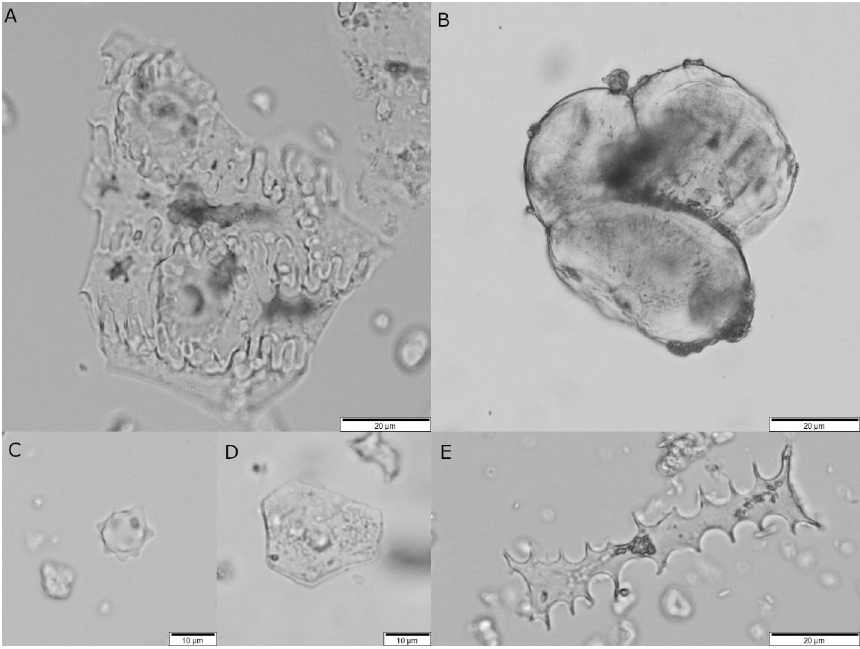
Fig 9. Phytoliths recovered in this study. A) silica skeleton from Panocoideae inflorescence; B) globular psilate mesophyll cells; C) globular echinate; D) papillae cell “cone” from Cyperaceae; E) Long dendritic cell from Triticeae. Pictures at 40x